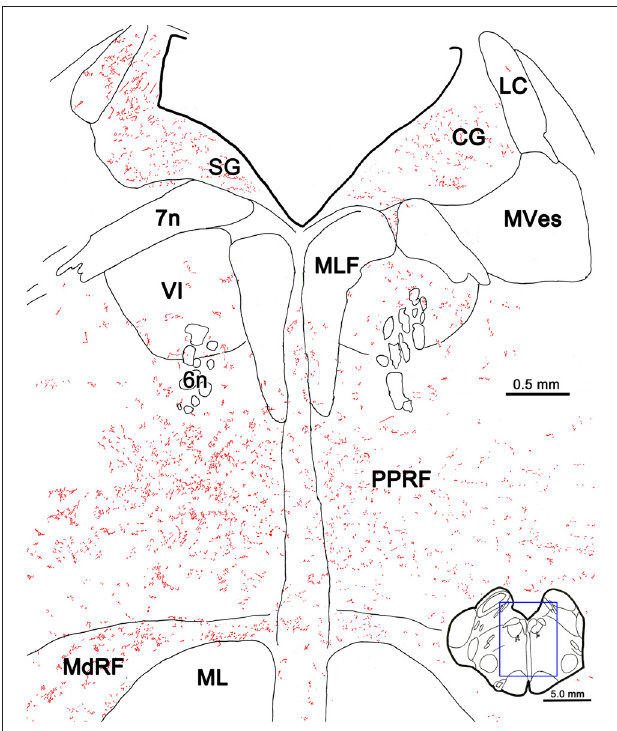
FIGURE 5 | PhaL labeled reticuloreticular axons at the level of the abducens nucleus. The pattern of reticuloreticular axons (lines) and terminals (stipple) is illustrated for the region shown by a box in the inset. The injection site is illustrated in Figure 4 . Note the ipsilateral predominance of the terminal labeling in the PRF and MdRF. FIGURE 6 | Morphology of reticuloreticular axons labeled by PhaL.